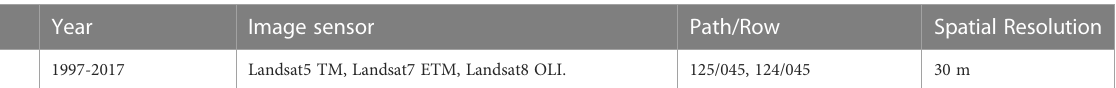
TABLE 1 List of land satellite image data of the Guangxi Beibu